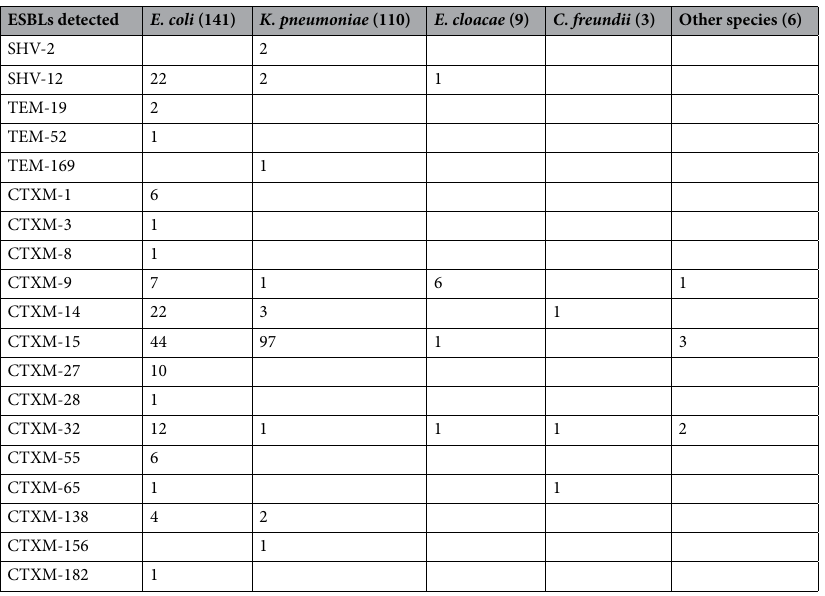
Table 4. ESBL genes identified in MDR-E isolated from patients with kidney, liver or combined kidney/ pancreas